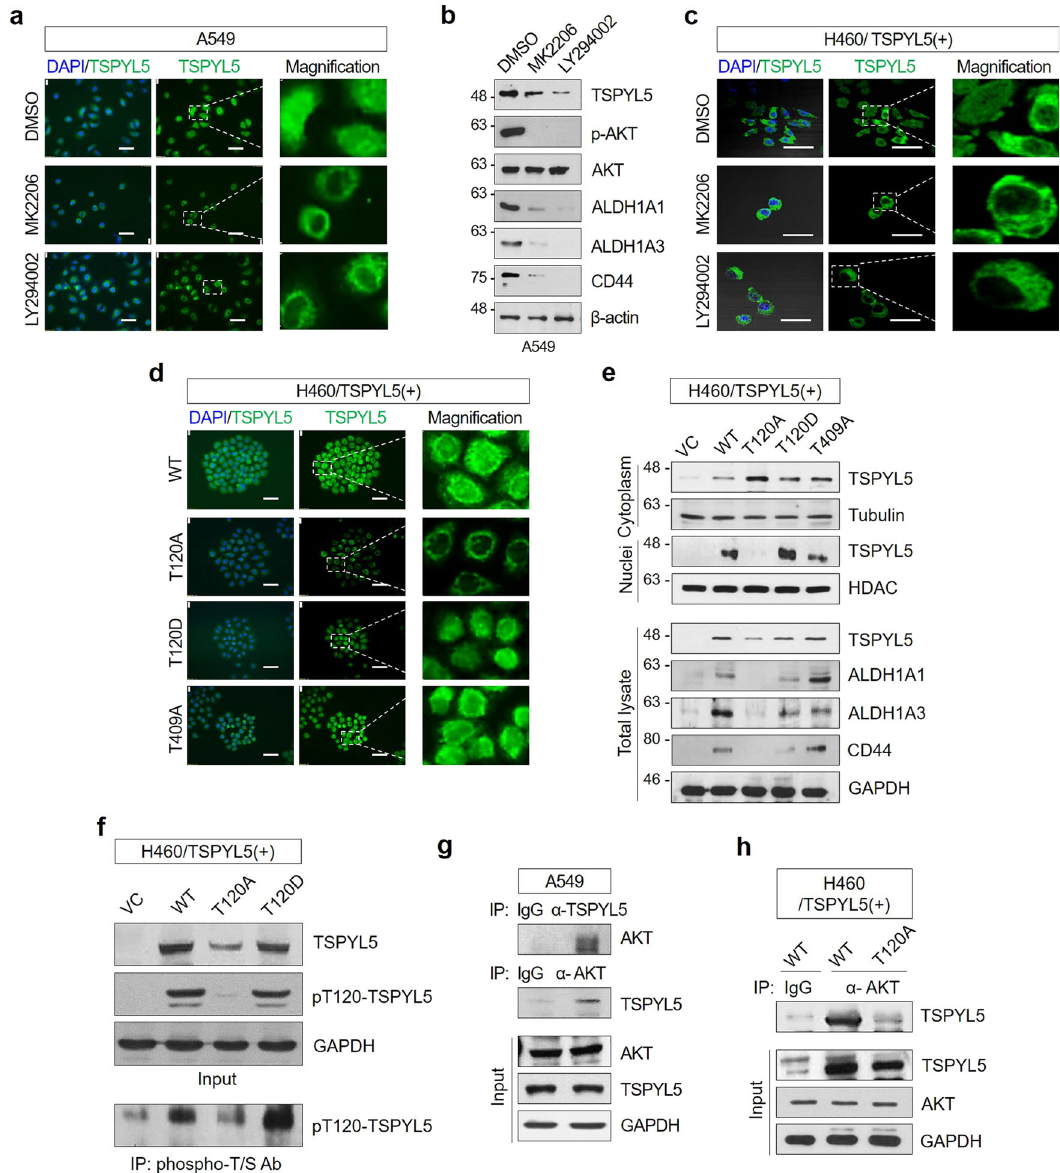
Fig. 5 AKT-mediated phosphorylation of TSPYL5 results in stabilization and nuclear translocation of TPYL5 and enhancement of CSC-like characteristics. a Reduction of nuclear TSPYL5 in A549 cells by treatment of the AKT inhibitor MK2206 (20 μ M) or the PI3K inhibitor LY294002 (10 μ M) for 4 h. Inserts of dashed-line boxes were magni fi ed in the right panel. Scale bar: 20 μ m. b Expression of TSPYL5 and CSC markers (ALDH1A1/A3, CD44) in A549 cells treated with AKT or PI3K inhibitors. c Reduction of nuclear TSPYL5 in TSPYL5-overexpressing H460 cells by treatment of the AKT inhibitor MK2206 or the PI3K inhibitor LY294002. d Intracellular localization of TSPYL5 mutants in H460 cells (WT: non-mutagenic TSPYL5 with T120, T120A: alanine mutant of T120 of TSPYL5, T120D: aspartic acid mutant of T120, and T409A: alanine mutant of T409). e Reduction and cytoplasmic retention of the TSPYL5-T120A mutant and suppression of ALDH1 and CD44 in H460 cells. The total cell lysates of H460 cells transfected with WT or site-directed mutagenic TSPYL5-expression vectors were fractionated into nuclei and cytoplasm, and TSPYL5 expressions were analyzed by Western blotting. Tubulin and HDAC were used as fraction-speci fi c markers. CSC markers (ALDH1A1/A3, CD44) were analyzed in TSPYL5-mutant-expressing H460 cells. VC: pcDNA3.1 vector-transfected control. f Phosphorylation of T120 in TSPYL5. Cell lysates from H460 cells transfected with non mutagenic (WT: T120) or site-directed mutagenic TSPYL5-expression (T120A or T120D) vectors or their immunoprecipitates with anti-phospho-threonine/serine (T/S) antibody were analyzed with anti-pT120-TSPYL5 antibody (see “ Methods ” ). g, h Coimmunoprecipitation assay showing a direct interaction between AKT and TSPYL5 in A549 cell lysates and H460 cells transfected with WT-TSPYL5 or T120A-TSPYL5 expression vector. Immunoprecipitations were performed with anti-TSPYL5 antibody or anti-AKT antibody. Immunoprecipitates and total cell lysates were analyzed by Western blotting